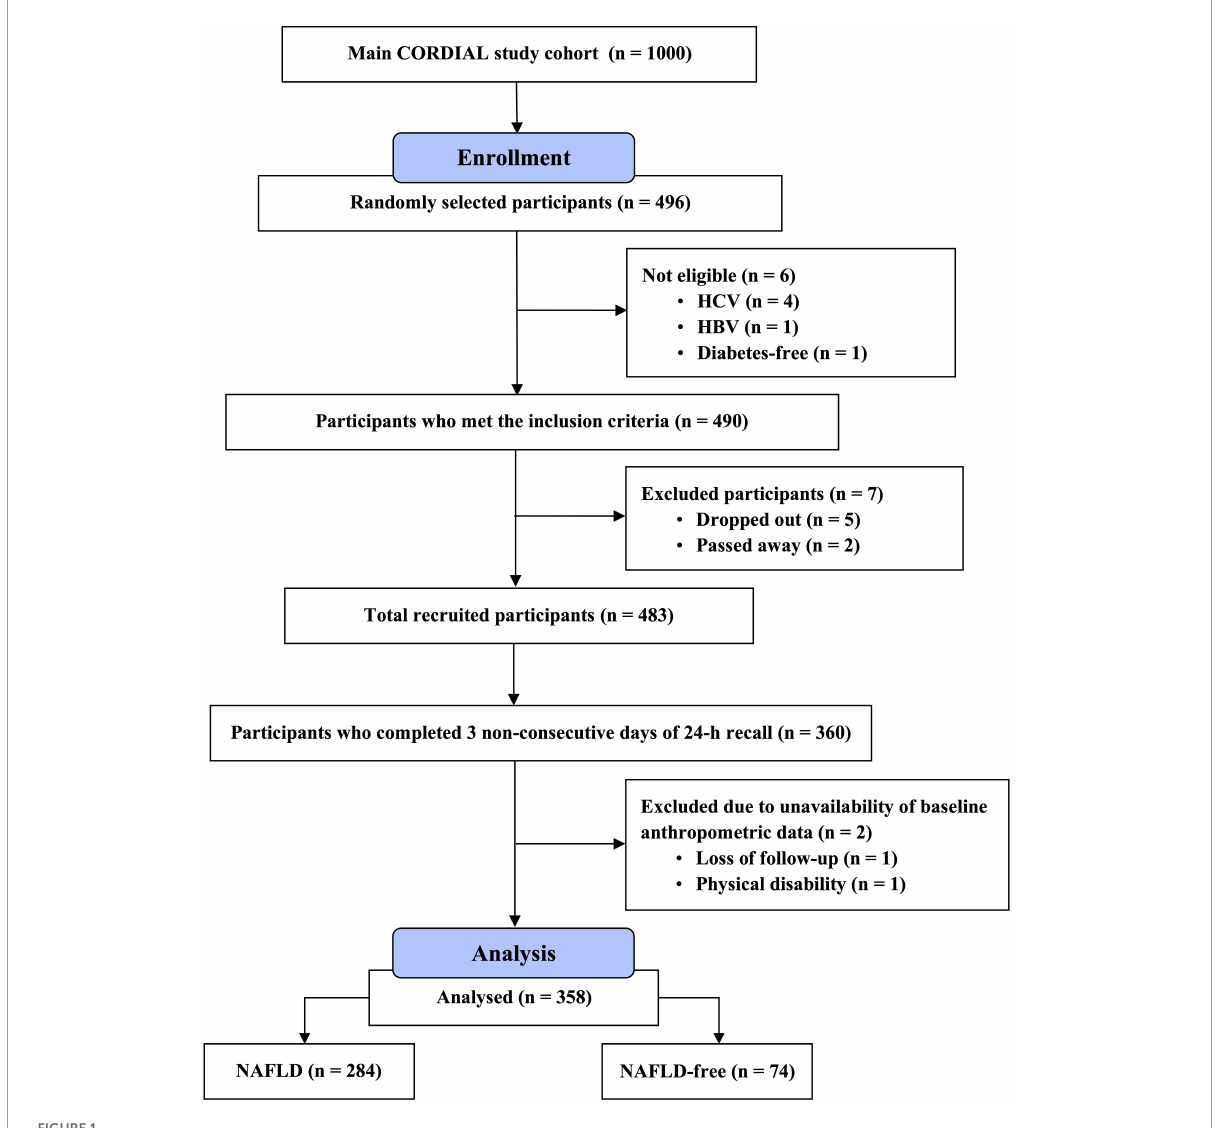
FIGURE1 A flow chart of the recruitment process.